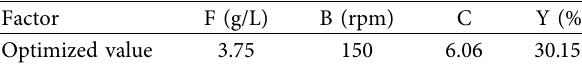
Figure 8: PVC weight loss percentage by each strain on Box − Behnken design trials. All the values are presented as the mean ± error of data from experiments performed as triplicates. Bars indicate the standard deviation of data. Control used was PVC resin on culture media with no bacterial exposure under the same fermentation time. Table 7: Optimized culture conditions for a maximum PVC Determination coefcients for Box − Behnken weight optimization model.